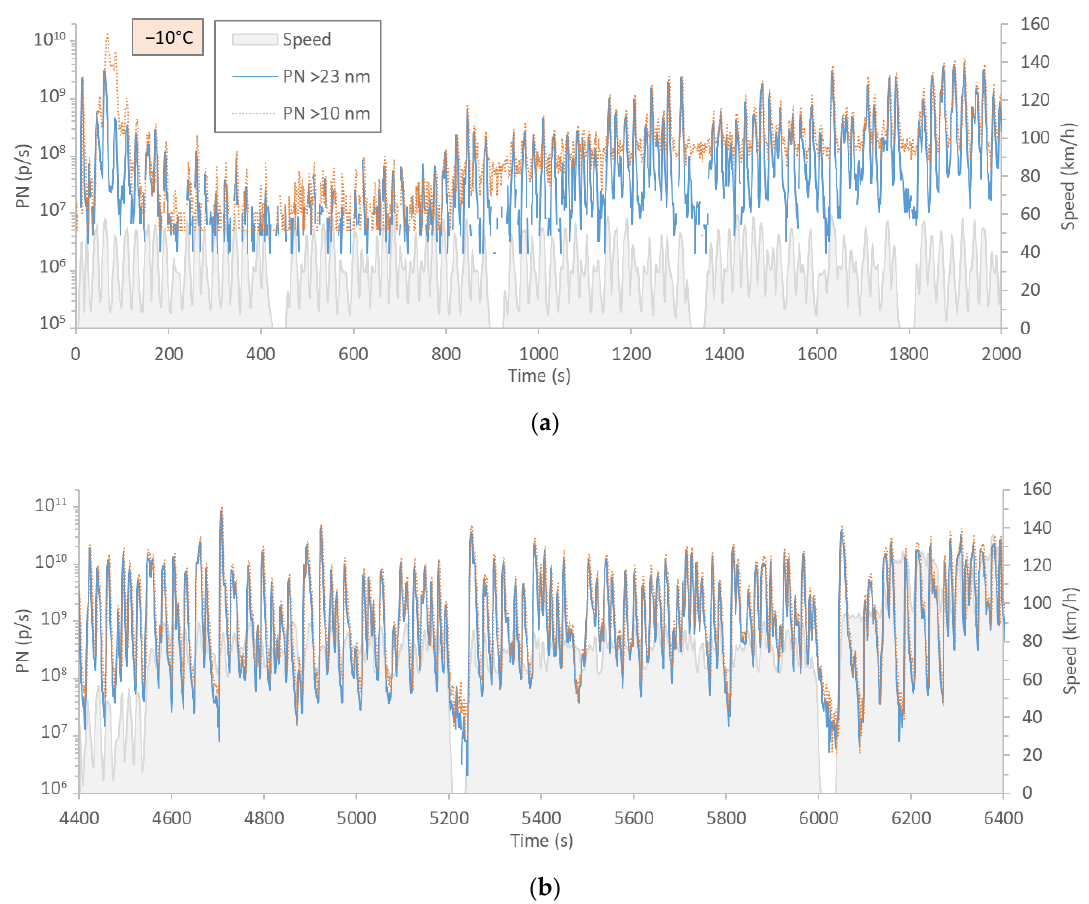
Figure 4. Particle number (PN) > 23 (blue line) and >10 nm (orange line) over sections of the dynamic RDE cycle at the boundaries of the RDE dynamicity limits (RDE boundary) driven on the chassis dynamometer at −10 °C: ( a ) urban section and; ( b ) parts of the urban, rural, and motorway sections. The speed profile is given in grey background.